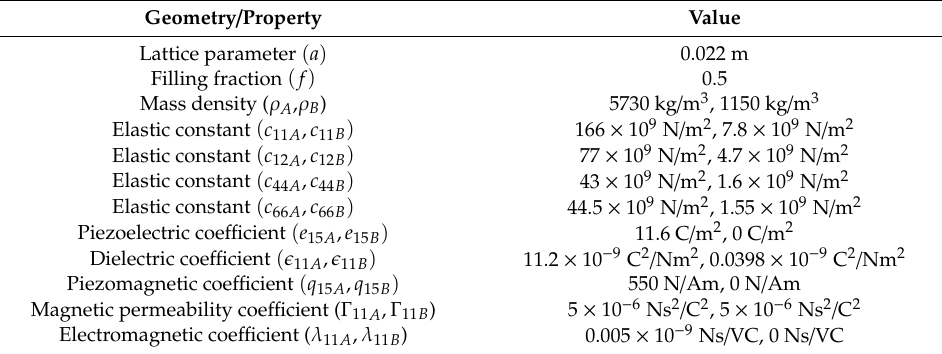
Table 1. Physical parameters of BaTiO 3 –CoFe 2 O 4 scatterers (A) and a polymeric matrix